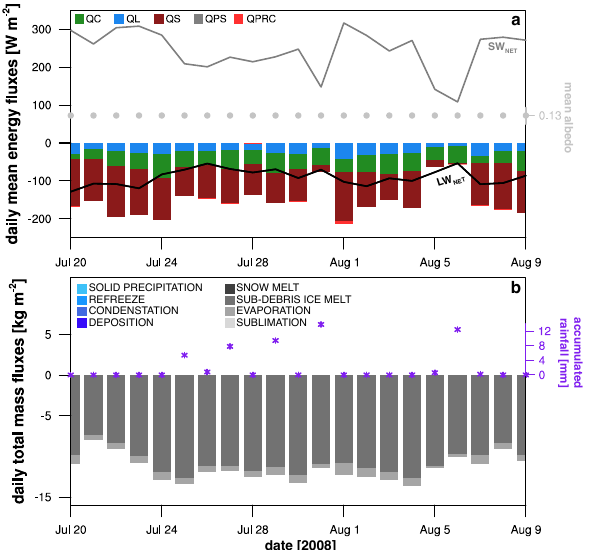
Figure 6. CMB-RES values for (a) daily mean energy fluxes over the evaluation period (Wm − 2 ). The grey curve is net shortwave radiation, the black curve is net longwave radiation, and the grey dots show daily-mean surface albedo, which remains constant at the debris value because there is no solid precipitation. (b) Daily total mass fluxes (kgm − 2 ). Maximum daily values of evaporation and condensation are 1.4 and 0.02kgm − 2 , respectively, although the latter flux is not visible. Note that while daily-accumulated rain- fall is shown (purple asterisks), it is not technically a mass flux, since the mass balance calculation in CMB-RES does not account for debris-water storage. Rather, this field is plotted to show its cor- respondence with other fields, such as net shortwave radiation.